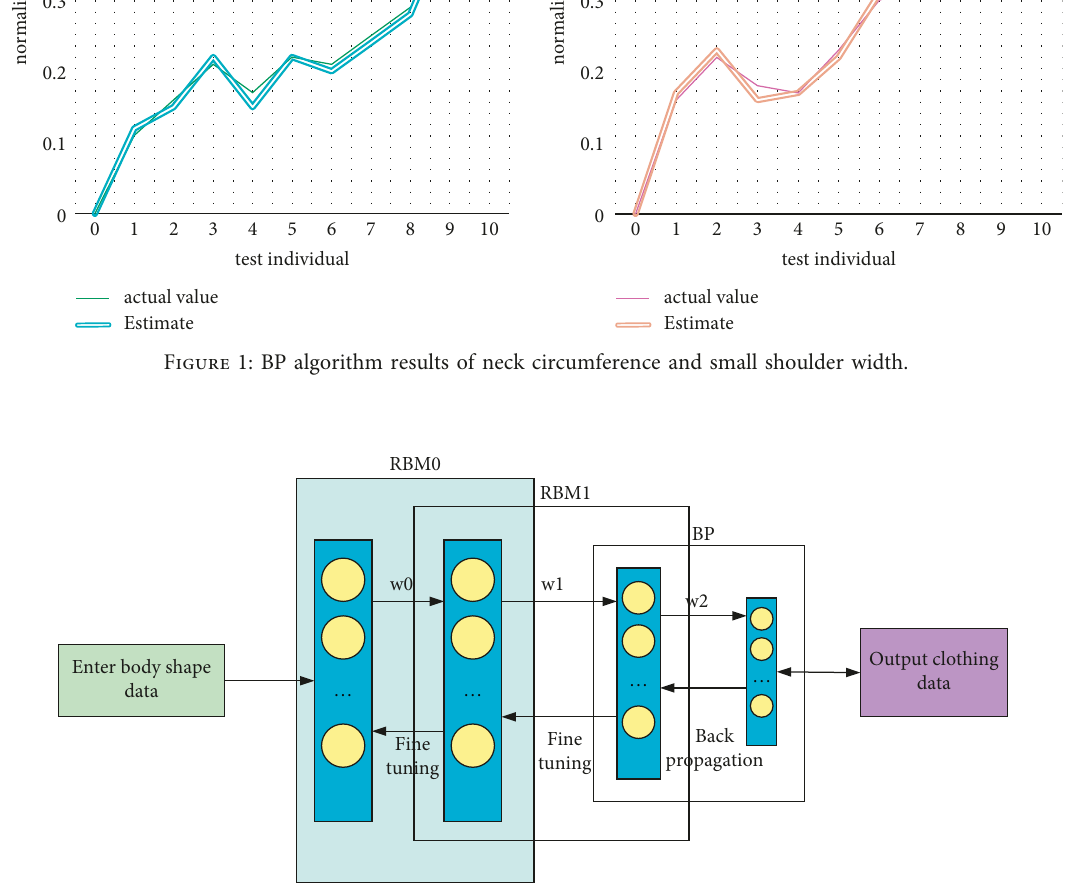
Figure 2: Deep belief network structure.